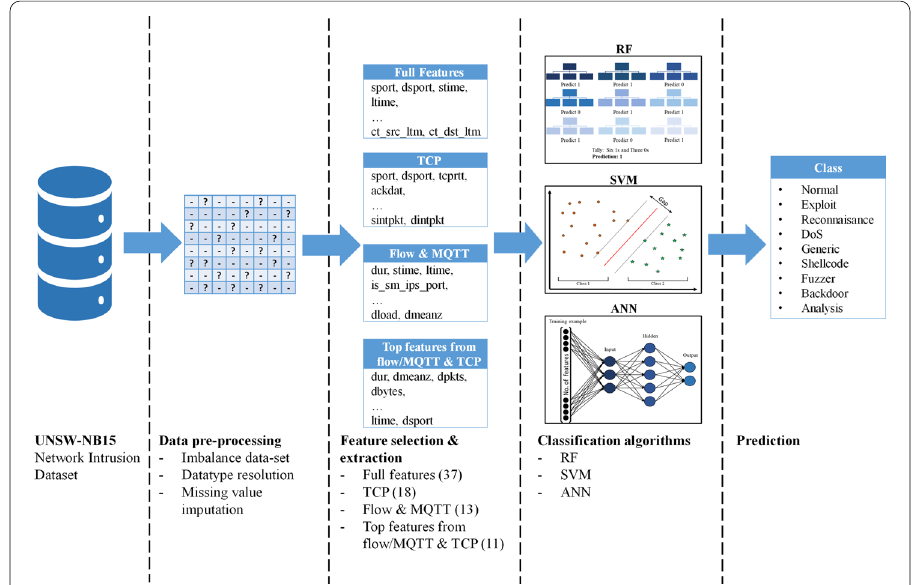
Fig. 1 Proposed framework for detecting cyber-attacks from IoT networks. Suggested system showing information flow as used in this research. UNSW-NB15 data-set is acquired and pre-processed, then features are extracted according to flow/MQTT and TCP protocols and four clusters are made. Three ML classifiers are used for classification on these